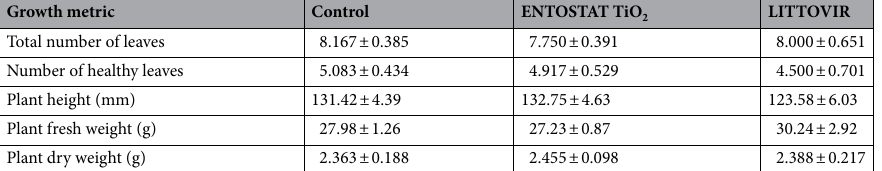
Table 1. Effect of virus formulation on cabbage plant growth after 16 days. n = 12 plants per formulation. Values shown are means ± S.E. Across each growth metric, there were no significant difference between the three formulations (LM: P > 0.05).